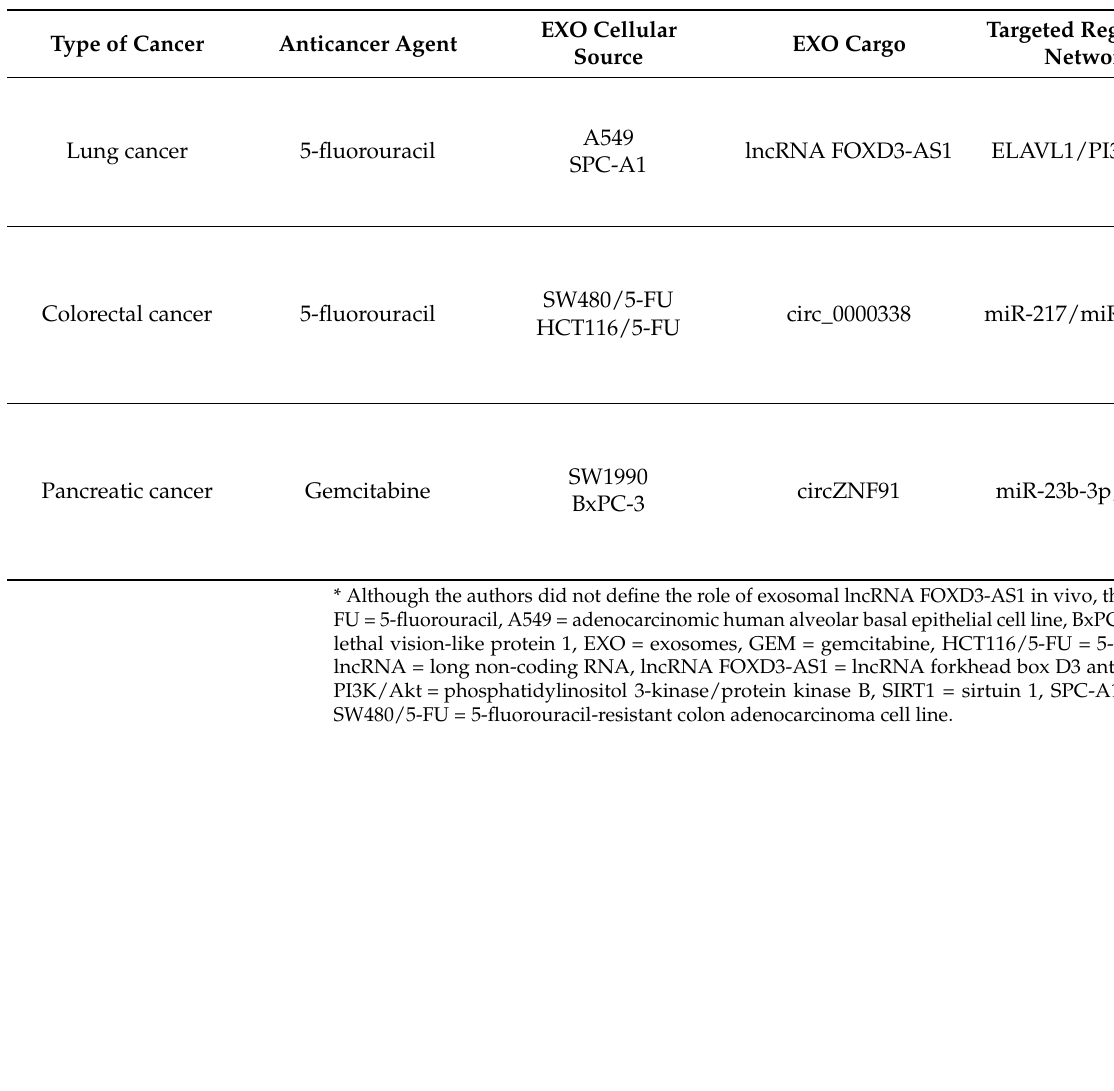
Table 3. Detailed analysis of exosomal non-coding RNAs (ncRNAs) mediated resistance to antimetabolite